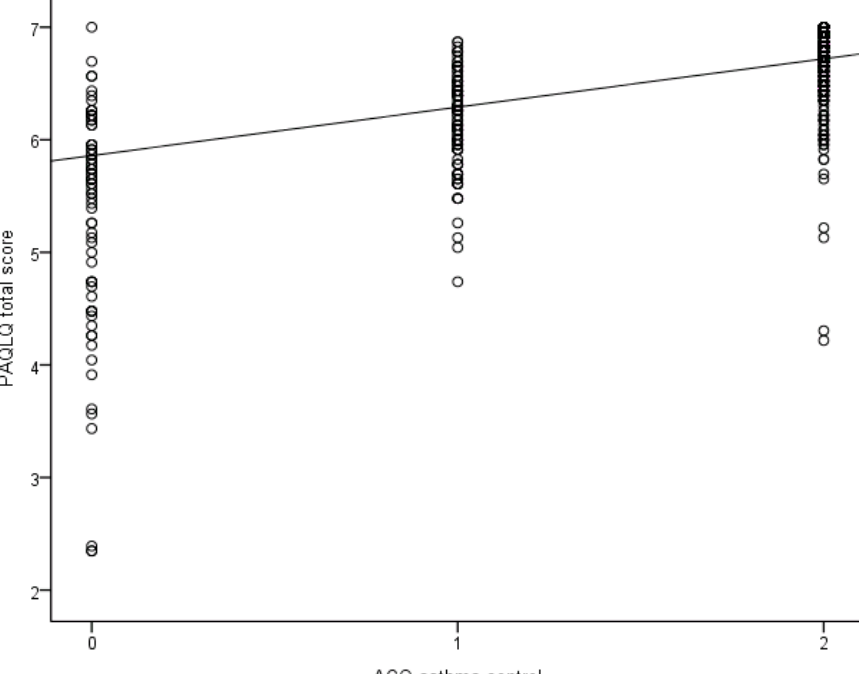
Figure 2. Associations between ACQ asthma control and PAQLQ total scores in a linear mixed model ― all measurements taken during one year were included. The regression line is based on a model in which the ACQ level of asthma control is included; the estimates of this model are given in Table 3. For factors in the equation other than ACQ asthma control, mean values were used. ACQ asthma control: 0 = uncontrolled, 1 = partly controlled, and 2 = controlled.